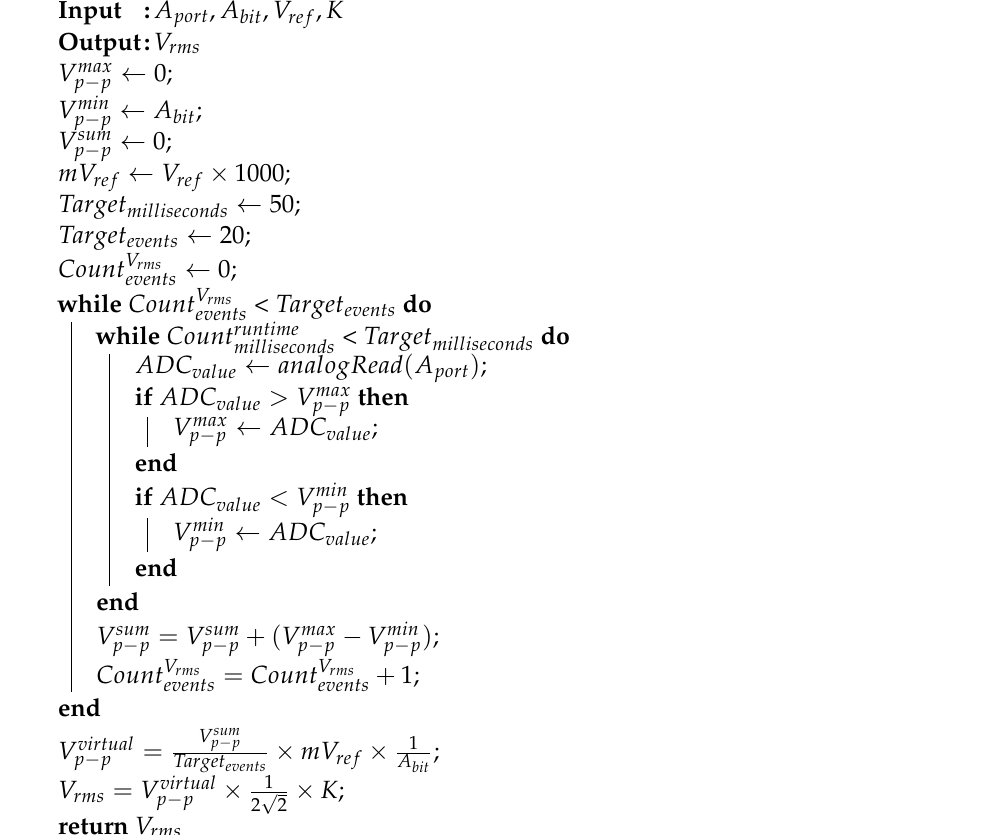
Algorithm 1: Voltage measurement with noise